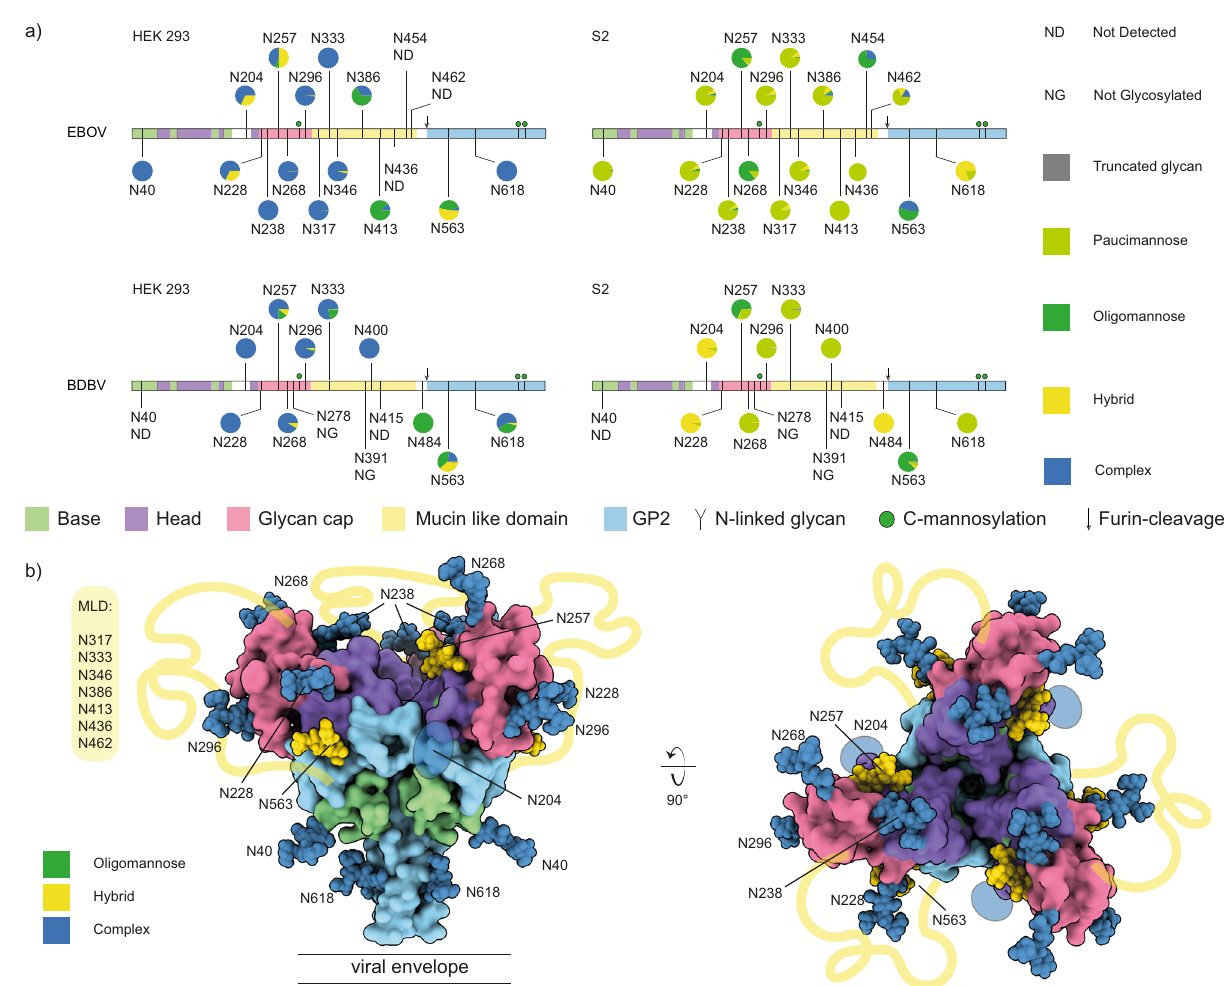
Fig. 2 N-linked glycosylation pro fi ling of ebolavirus GP. a Overview of site-speci fi c N-linked glycan processing in ebolavirus GP Δ TM from HEK293 and S2 cells as determined by LC-MS/MS. The glycans were classi fi ed by HexNAc content as truncated, paucimannose, oligomannose, hybrid or complex. Shown is the average of a duplicate experiment. b Pseudomodel of EBOV GP (as in Fig. 1), with glycans colored by main class (oligomannose, hybrid, complex) as observed in HEK293